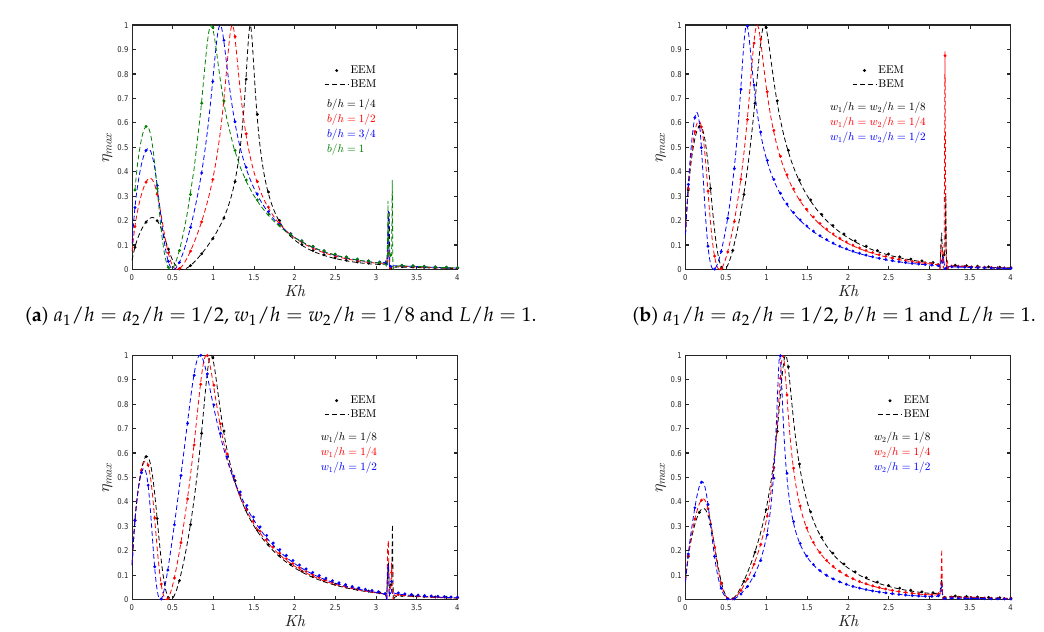
Figure 11. Maximum hydrodynamic efficiency η max versus the non-dimensional frequency Kh for different ( a ) lengths of the OWC chamber b / h ; ( b ) thickness of the rear and front walls, w 1 / h and w 2 / h , respectively; ( c ) thickness of the rear wall w 1 / h ; ( d ) thickness of the front wall w 2 / h